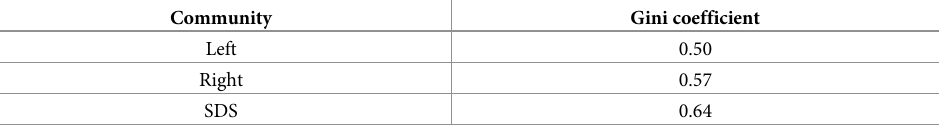
Table 7. Gini coefficients of influence distribution for the three major communities at the last timepoint, t =